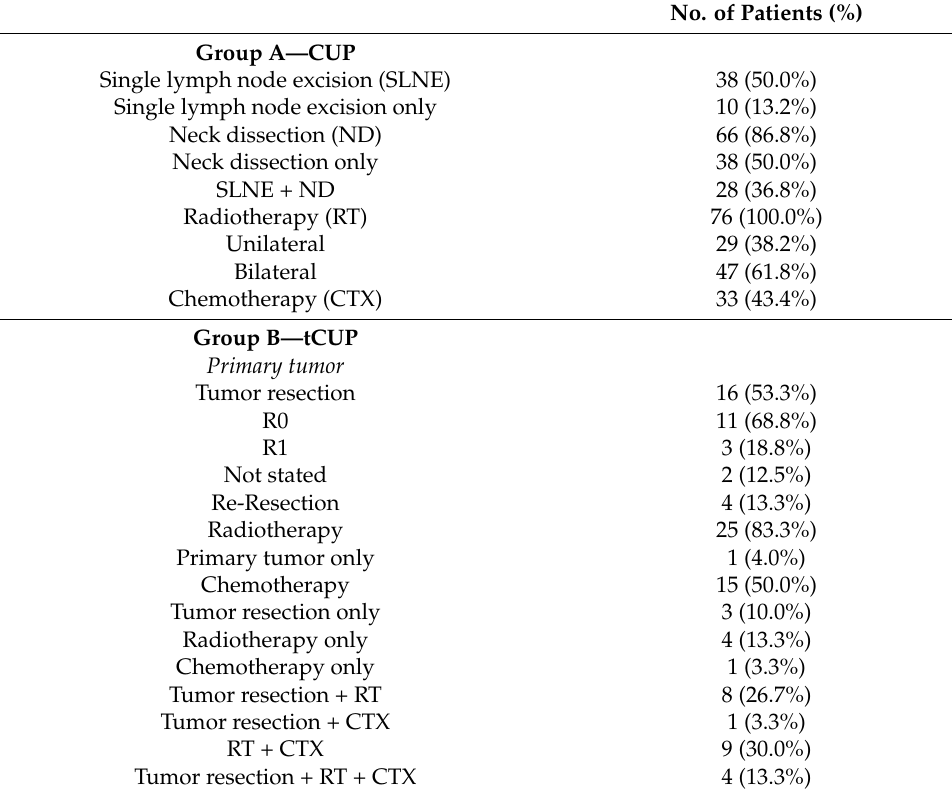
Table 4. Treatment methods and clinical